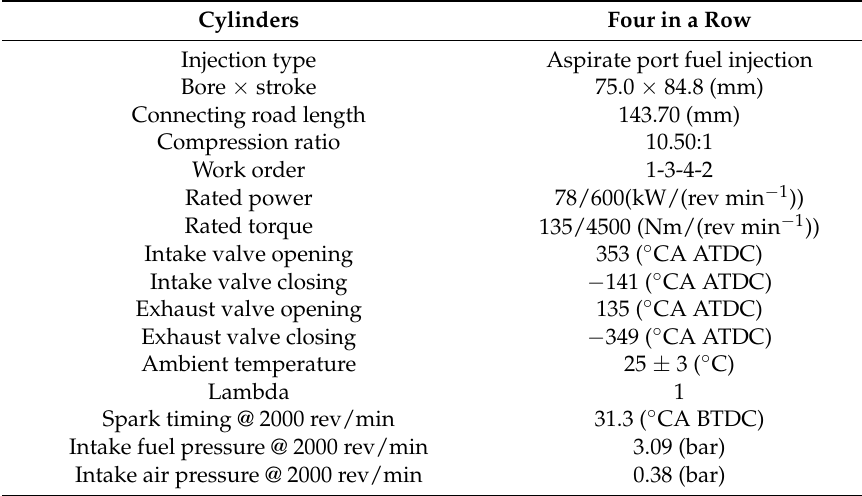
Table 1. Details of the experimental gasoline engine.